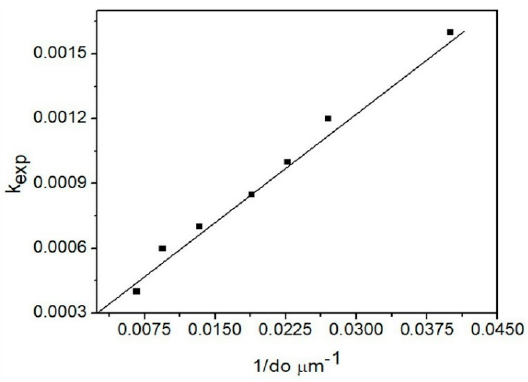
Figure 8. k exp versus the inverse of particle diameter. (V = 0.5 L, 40 g ∙ L − 1 Mineral, PO 2 = 1 atm, pH = 10, leaching time = 240 min, [S 2 O 32 − ] = 0.16 mol ∙ L − 1 , [Cu 2+ ] = 0.006 mol ∙ L − 1 , 298 K, RPM = 750 min − 1 ).